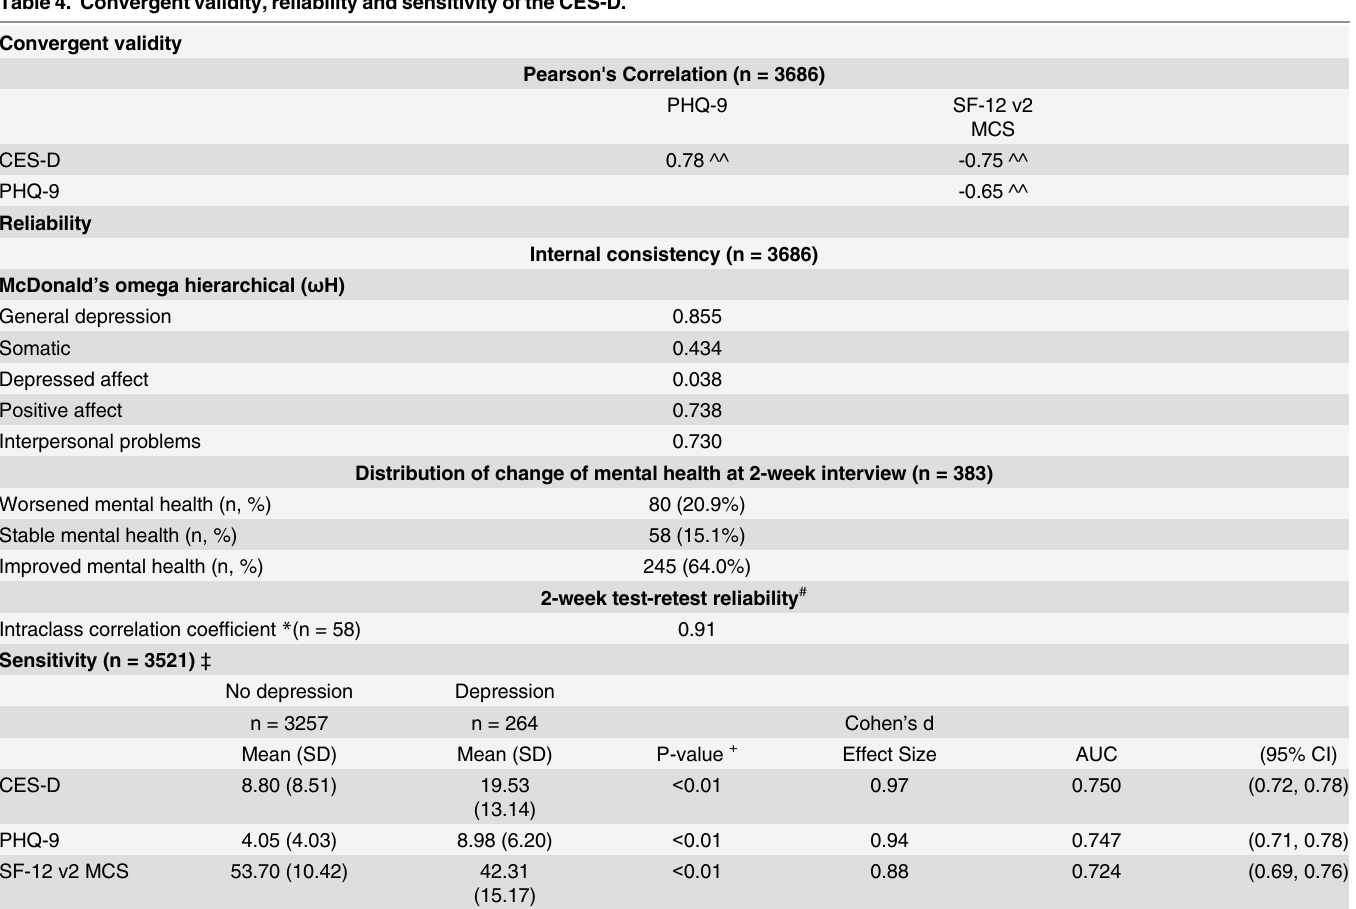
Table 4. Convergent validity, reliability and sensitivity of the